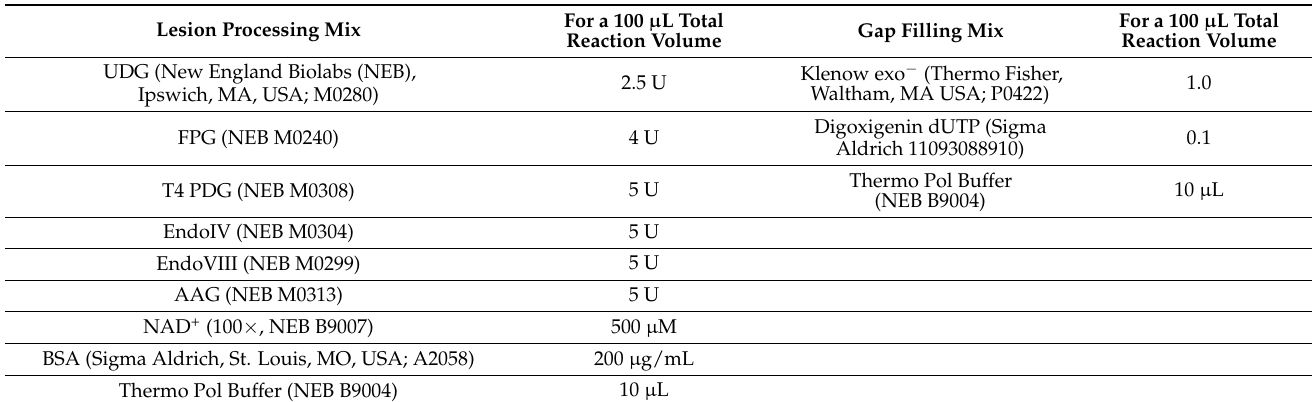
Table 1. Broad spectrum Full RADD assay cocktail.